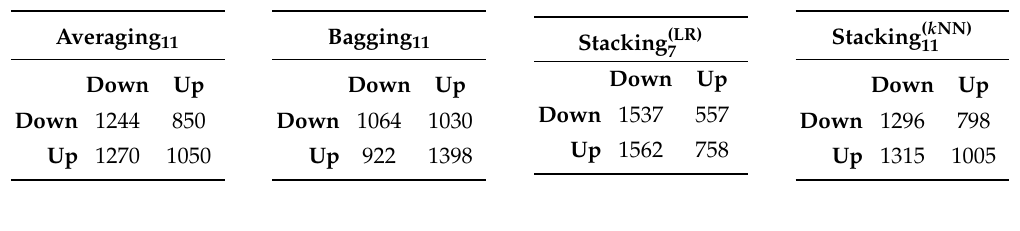
and Stacking ( k NN) using 7 11